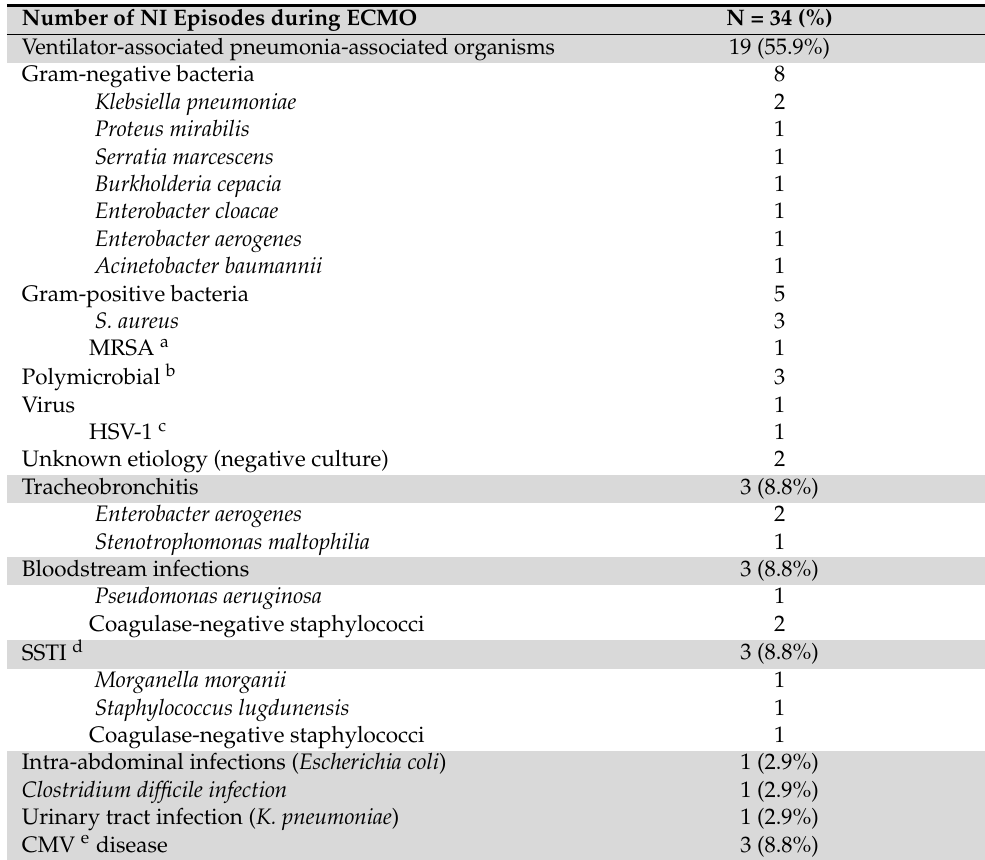
Table 3. Site of infection and associated microorganisms. Number of NI Episodes during